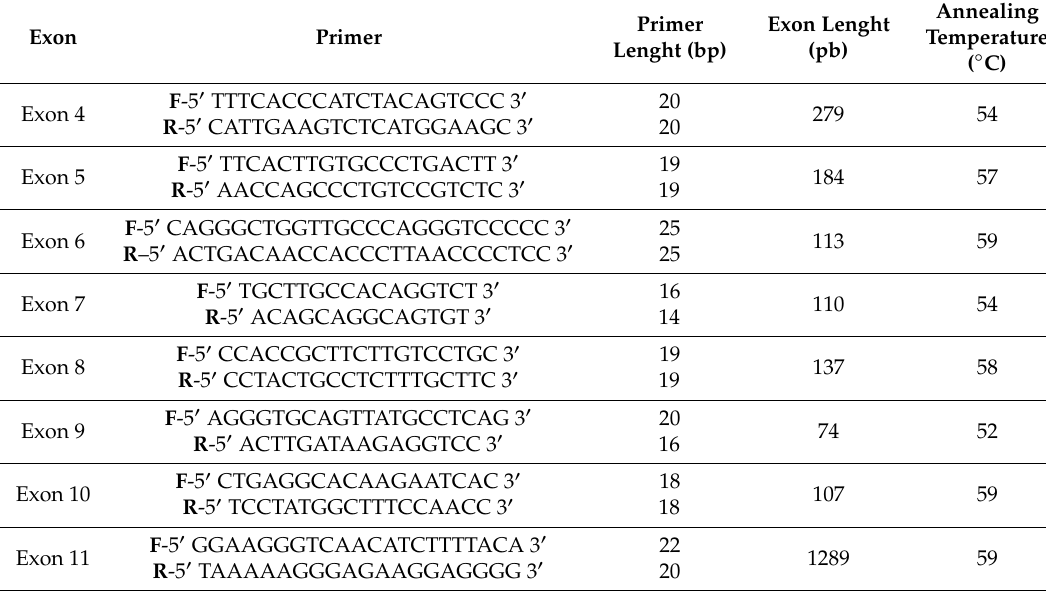
Table 8. Primers used for TP53 gene.